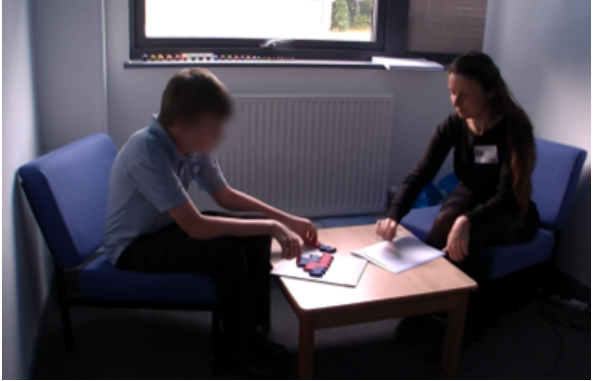
Figure 14: ADOS assessment with